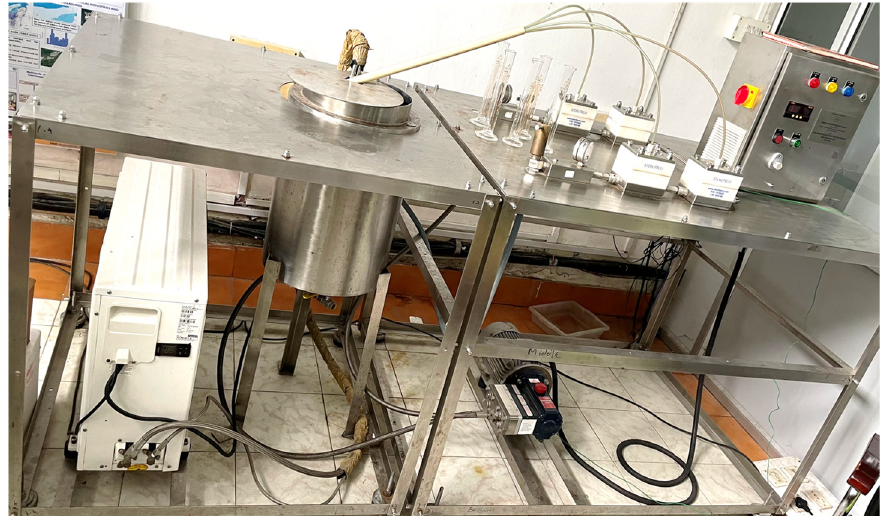
Figure 2. The crossflow NF/RO (Nanofiltration/Reverse Osmosis) four-cell membrane testing unit.